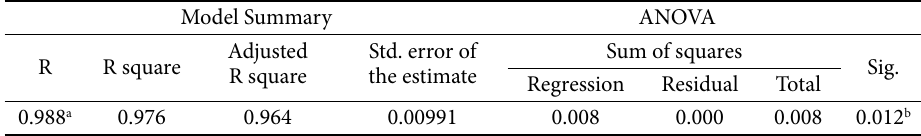
Table 6. Indices of the distribution of households in the Republic of Lithuania in accordance with a household’s ability to make ends meet and shadow economy power interdependence and the model’s quality, 2008–2011 Model Summary ANOVA Adjusted Std. error of R R square R square the estimate